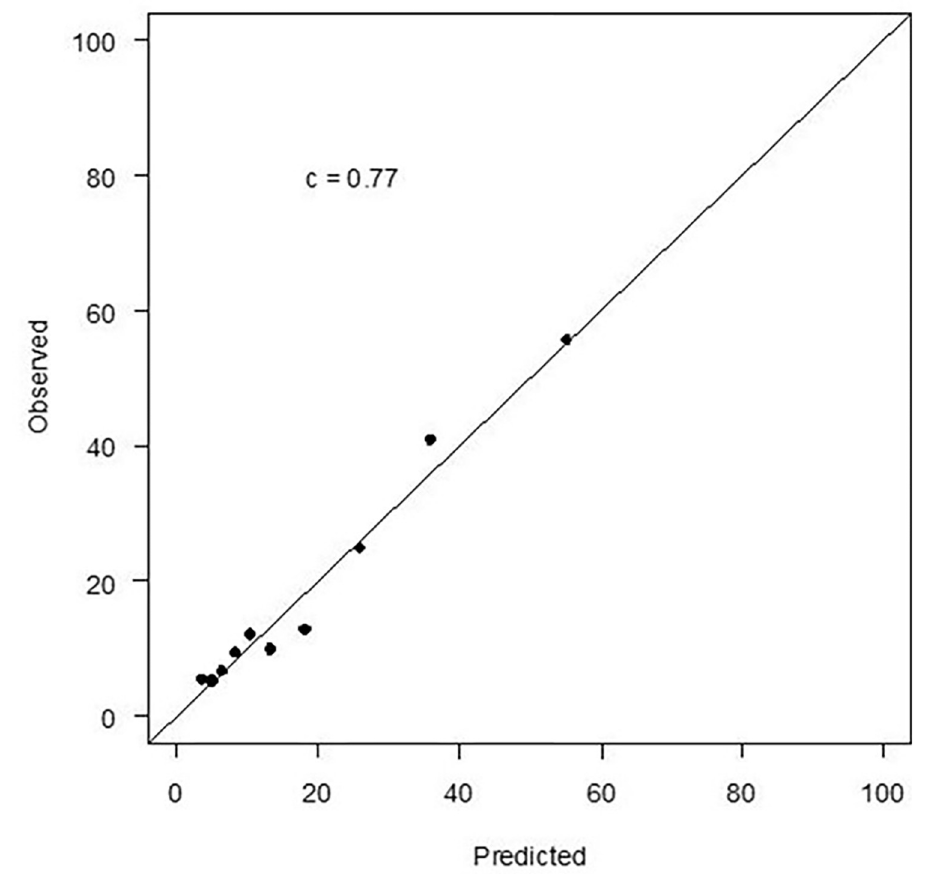
Fig 2. External validation of the predictive model in the PORTRAIT